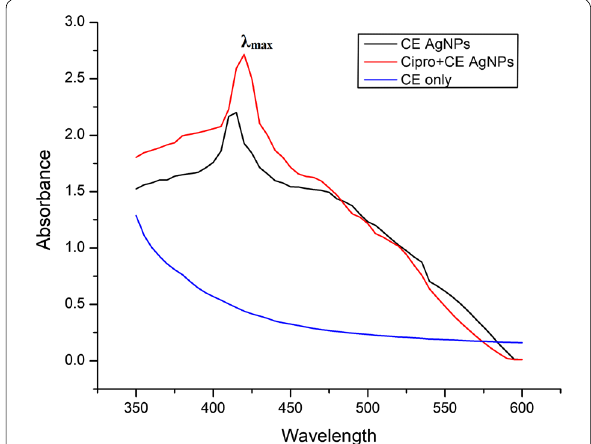
Fig. 1 UV–Vis spectra of callus extract (CE) mediated AgNPs and